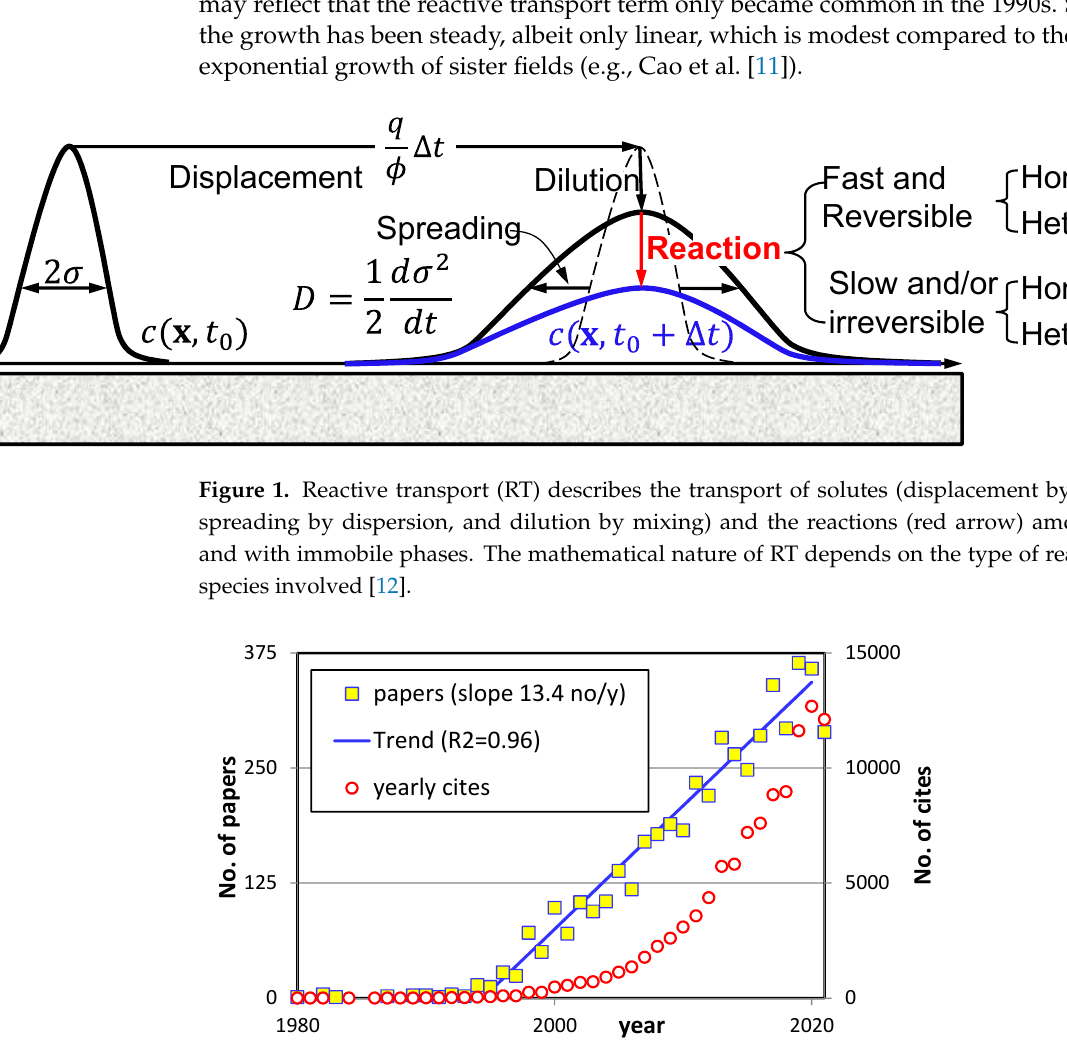
Figure 2. The number of papers identified as dealing with RT in the SCIE has increased linearly since 1993.